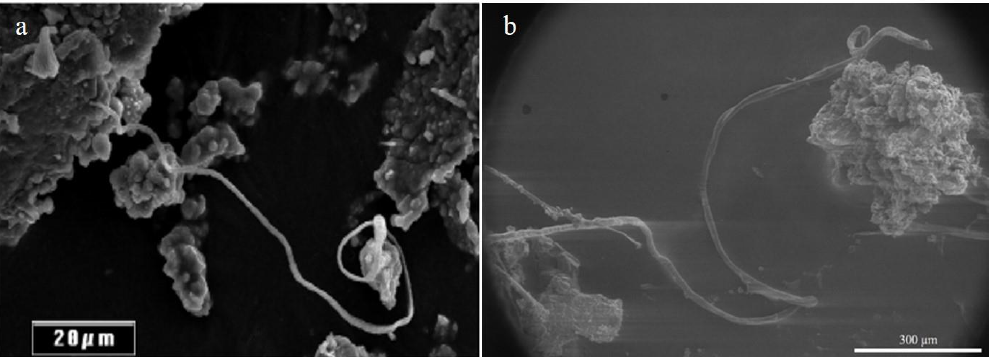
Figure 6. ( a ) A long helical coil observed in the Orgueil meteorite [54] . ( b ) A similar long thread